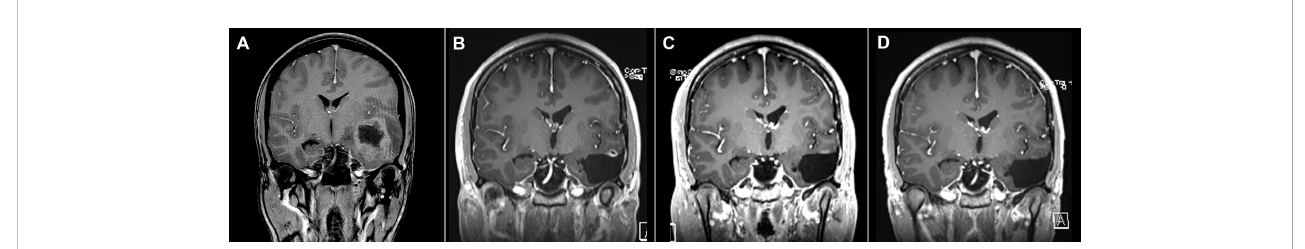
FIGURE 4 26-year-old female (A) November 2017, 1.5 Tesla scanner: T1-weighted postcontrast gradient echo preoperative image showing GBM in the left temporal region. (B) April 2019, T1-weighted postcontrast gradient echo image showing long-lasting postoperative enhancement suspicious of residual tumor. (C) August 2019, T1-weighted postcontrast gradient echo image reveals a decrease in enhancement. (D) March 2022, T1-weighted postcontrast gradient echo image with no signs of tumor recurrence.